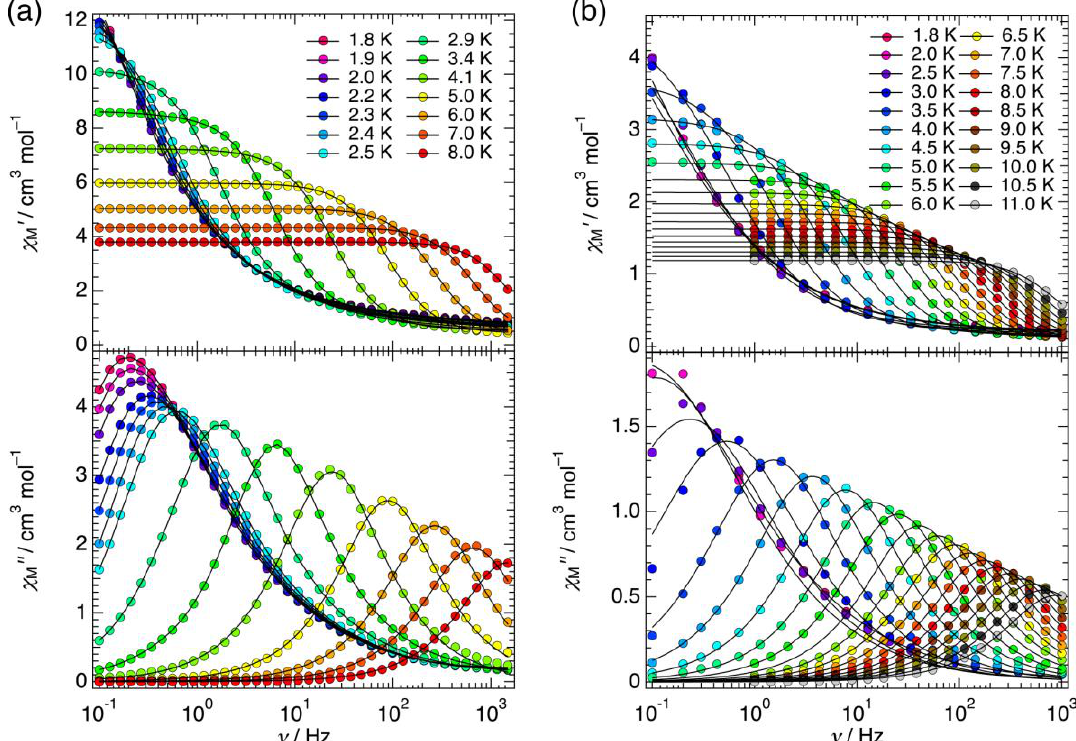
Figure 7. ν-dependent χ M and χ M in the T range 1.8–8.0 K in an applied H DC of 950 Oe for 1 ( a ) and in the T range 1.8–11.0 K in an applied H DC of 1500 Oe for 3 ( b ), respectively. Solid black lines represent best fits to a generalized Debye model.